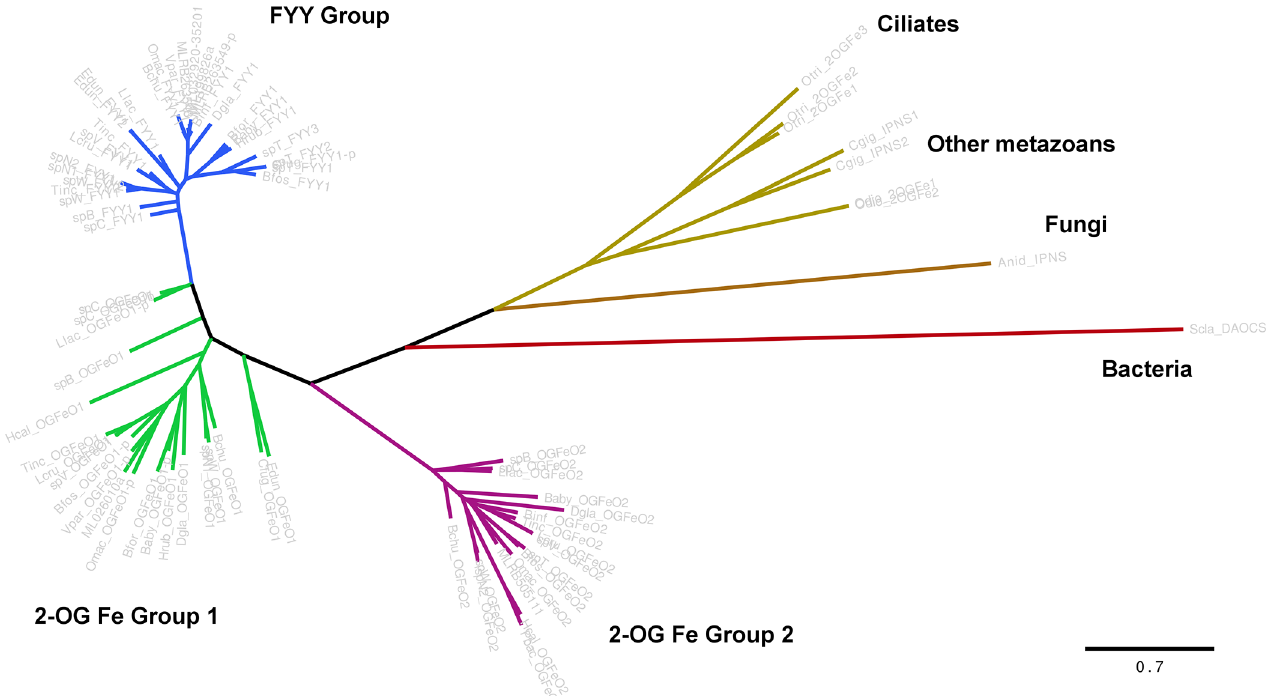
Fig 5. Maximum-likelihood tree of all putative ctenophore non-heme oxygenase protein sequences. Maximum-likelihood tree of all ctenophore non- heme oxygenase proteins including both FYY-containing (blue branches) and two non-FYY groups (green and purple branches). Outgroups from top BLAST hits (gold branches) and model enzymes (brown and red branches) show long branches compared to the FYY proteins. Sequence names are grayed out to emphasize branch lengths and clustering of the proteins. Scale bar indicates substitutions per site. Partial or incomplete sequences are indicated by - p as in Fig 4. Species abbreviations are as follows: Anid, Aspergillus nidulans ; Bfos, Bathocyroe fosteri ; Bchu, Bathyctena chuni ; Baby, Beroe abyssicola ; Bfor, Beroe forskalii ; Binf, Bolinopsis infundibulum ; Cfug, Charistephane fugiens ; Cgig, Crassostrea gigas ; Dgla, Dryodora glandiformis ; Edun, Euplokamis dunlapae ; Hrub, Haeckelia rubra ; Hcal, Hormiphora californensis ; Llac, Lampea lactea ; Lcru, Lampocteis cruentiventer ; ML, Mnemiopsis leidyi ; Odio, Oikopleura dioica ; Omac, Ocyropsis maculata ; Otri, Oxytricha trifallax ; Pbac, Pleurobrachia bachei ; Scla, Streptomyces clavuligerus ; Tinc, Thalassocalyce inconstans ; spB, Undescribed ctenophore B ; spC, Undescribed ctenophore C ; spN1, Undescribed ctenophore N1 ; spN2, Undescribed ctenophore N2 ; spT, Undescribed ctenophore T ; spV, Undescribed ctenophore V ; Vpar, Velamen parallelum